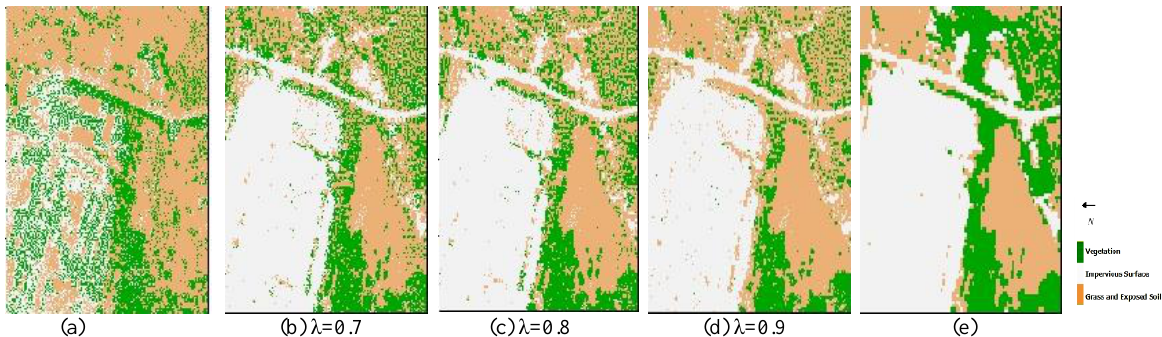
Fig.3. Initial SRM (a) Optimum SRM generated using fuzzy class definitions for λ=0.7(b), λ=0.8(c), λ=0.9(d) respectively and the MLC classified reference image (e).